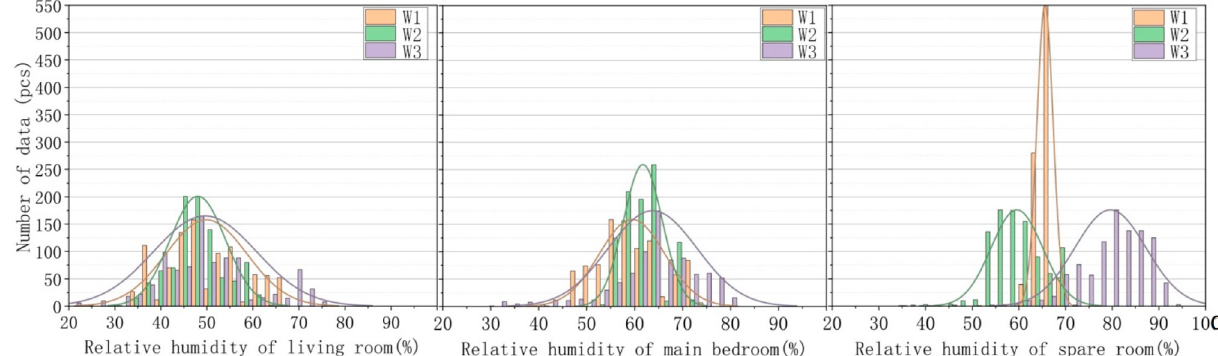
Figure 22. Distribution of indoor relative humidity data in winter.